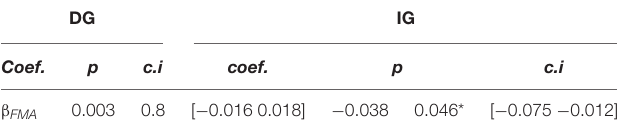
FMA, subjects frontomedial activity. ∗ indicates statistical significance at